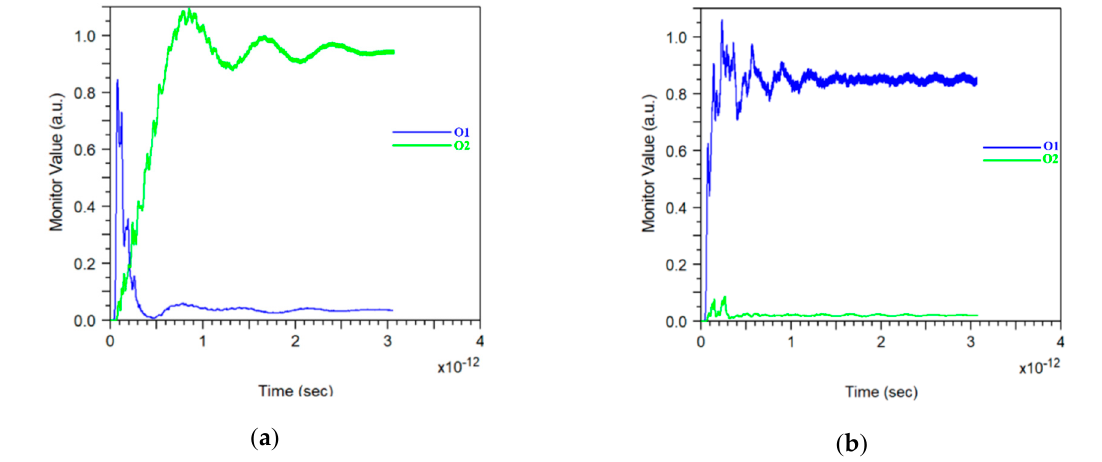
Figure 6. The normalized output power for: ( a ) I = 0.45 W / µ m 2 ; ( b ) I = 0.1 W / µ m 2 .